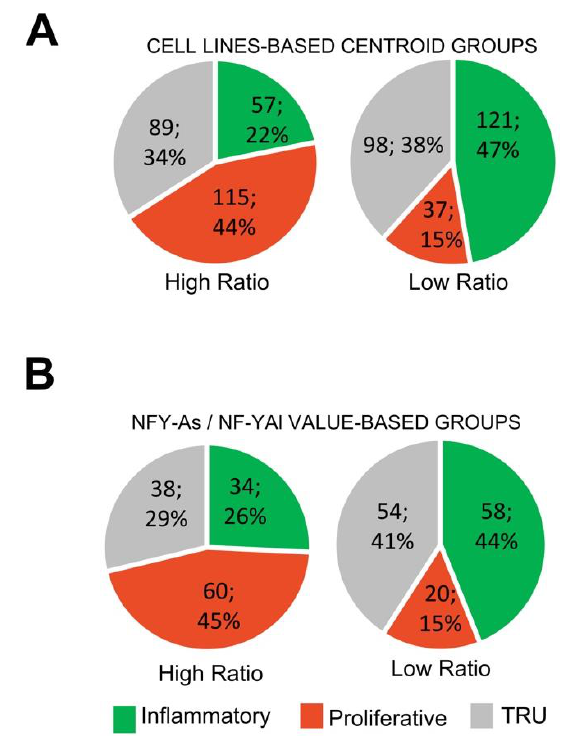
Figure 7. LUAD subclasses have different NF-YAs/NF-YAl ratios. ( A ) Subgroup distribution of LUAD tumors partitioned in high (left) and low (right) NF-YAs/NF-YAl ratios, according to the cell line-based centroids. ( B ) Subgroup distribution of LUAD tumors partitioned on the basis of sample NF-YAs/NF-YAl ratios.